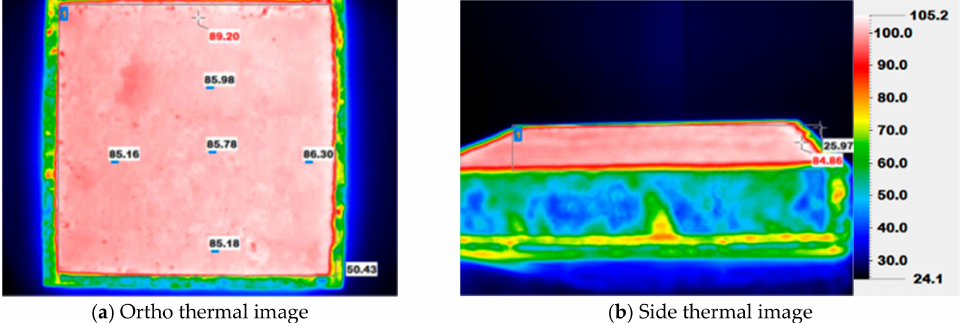
Figure 9. SMA-graded mixture thermal image ( ◦ C).